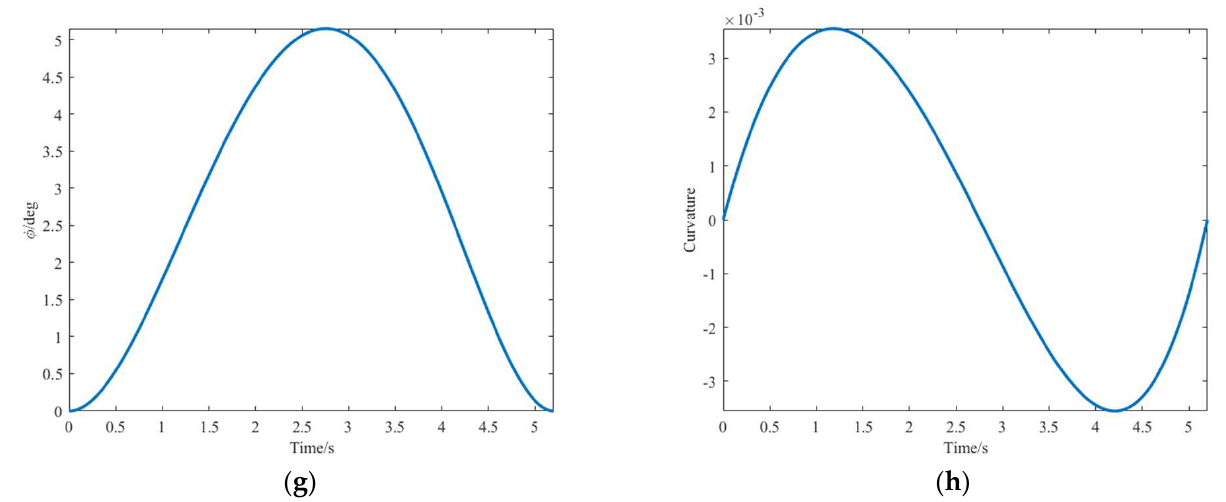
Figure 9. Driving state of the ego vehicle under optimal lane changing trajectory. ( a ) Longitudinal displacement curve. ( b ) Lateral displacement curve. ( c ) Longitudinal velocity curve. ( d ) Lateral velocity curve. ( e ) Longitudinal acceleration curve. ( f ) Lateral acceleration curve. ( g ) Heading angle curve. ( h ) Curvature curve.